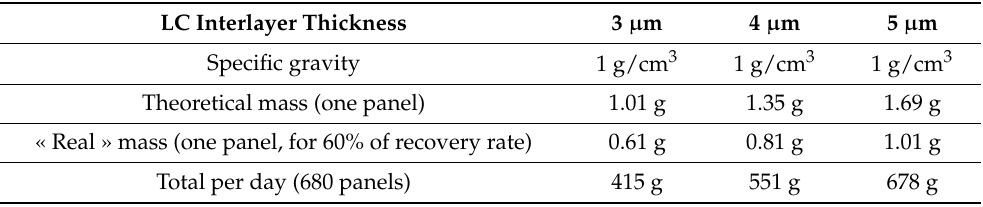
Table 5. Evaluation of mass of extracted LC from EOL-LCD (panels of 35-inch